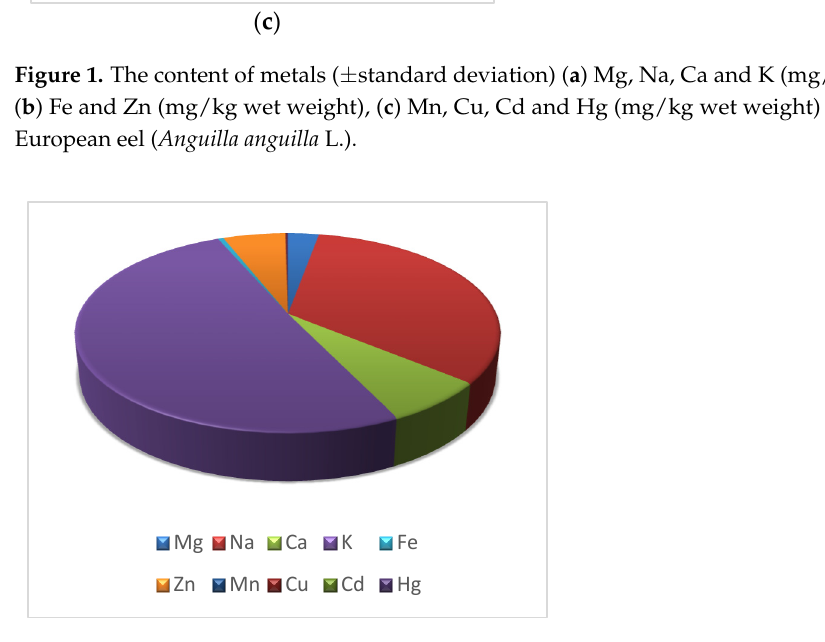
Figure 2. The content of metals in muscles of the European eel ( Anguilla anguilla L.). Mg, Ca, Na, and K (mg/100 g wet weight); Cu, Zn, Mn, Fe, Hg, and Cd (mg/kg wet weight).